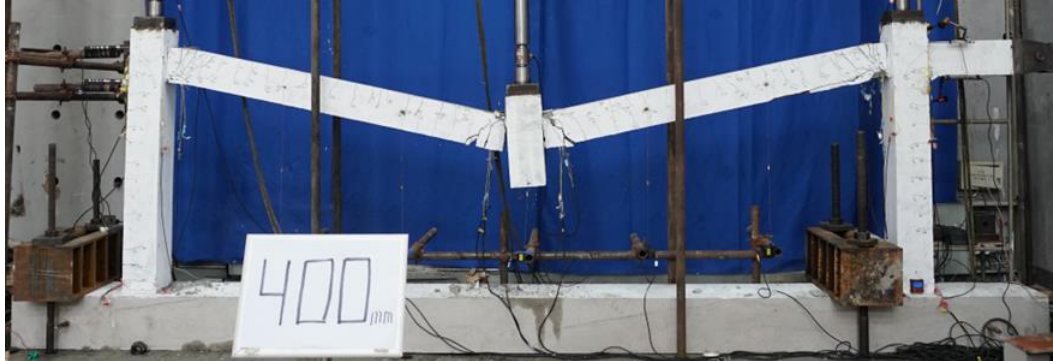
Figure 6. A single-storey reinforced concrete frame under progressive collapse .